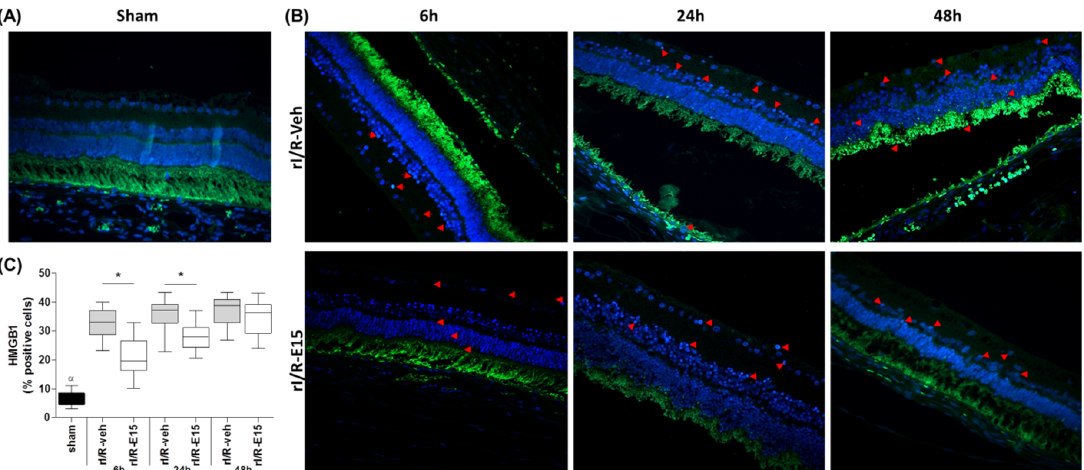
Figure 4. The protective effect from rI/R by E15 in the timeline. Necrosis was determined by high-mobility group box-1 (HMGB1) immunostaining assay. ( A ) Sham group at 48 h; ( B ) rI/R-veh at 6, 24, and 48 h after rI/R (upper panel) and E15-treated groups at the same times; (bottom panel). ( C ) Box-and-whisker plot (median, first-third quartile, minimum- maximum value) with the percentage of positive cells. Representative necrotic cells are shown with red arrows and their nuclei stained with DAPI (blue). * p < 0.05 compared to rI/R-veh α p < 0.01 compared to rI/R-veh and rI/R-E15 groups, at 48 h. Scale bar = 100 μm.